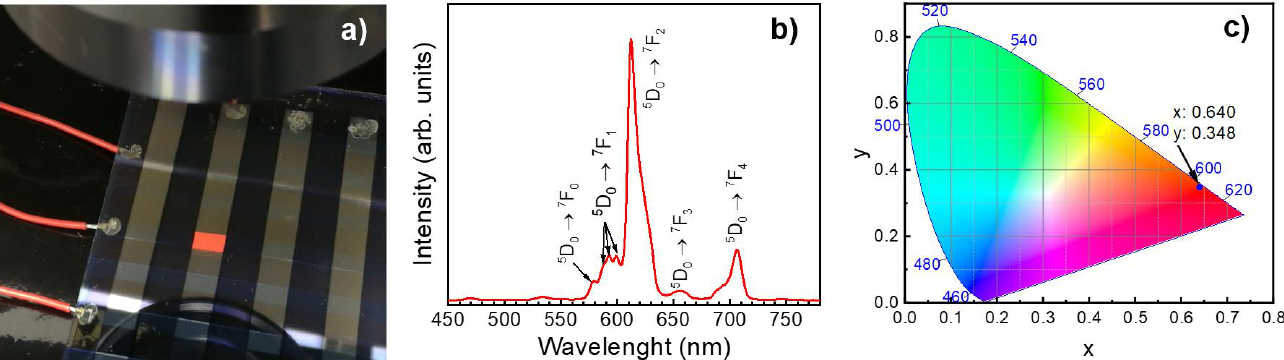
Figure 4. ( a ) Photograph of a 3 × 5 mm 2 red Y 2 O 3 :Eu/ZnS-based EL pixel emitting an intensity of 40 cd/m 2 . The pixel was measured under normal room lighting. ( b ) Electroluminescence spectrum of the pixel shown in ( a ). ( c ) CIE 1931 chromatography diagram deduced from the spectrum in ( b ).